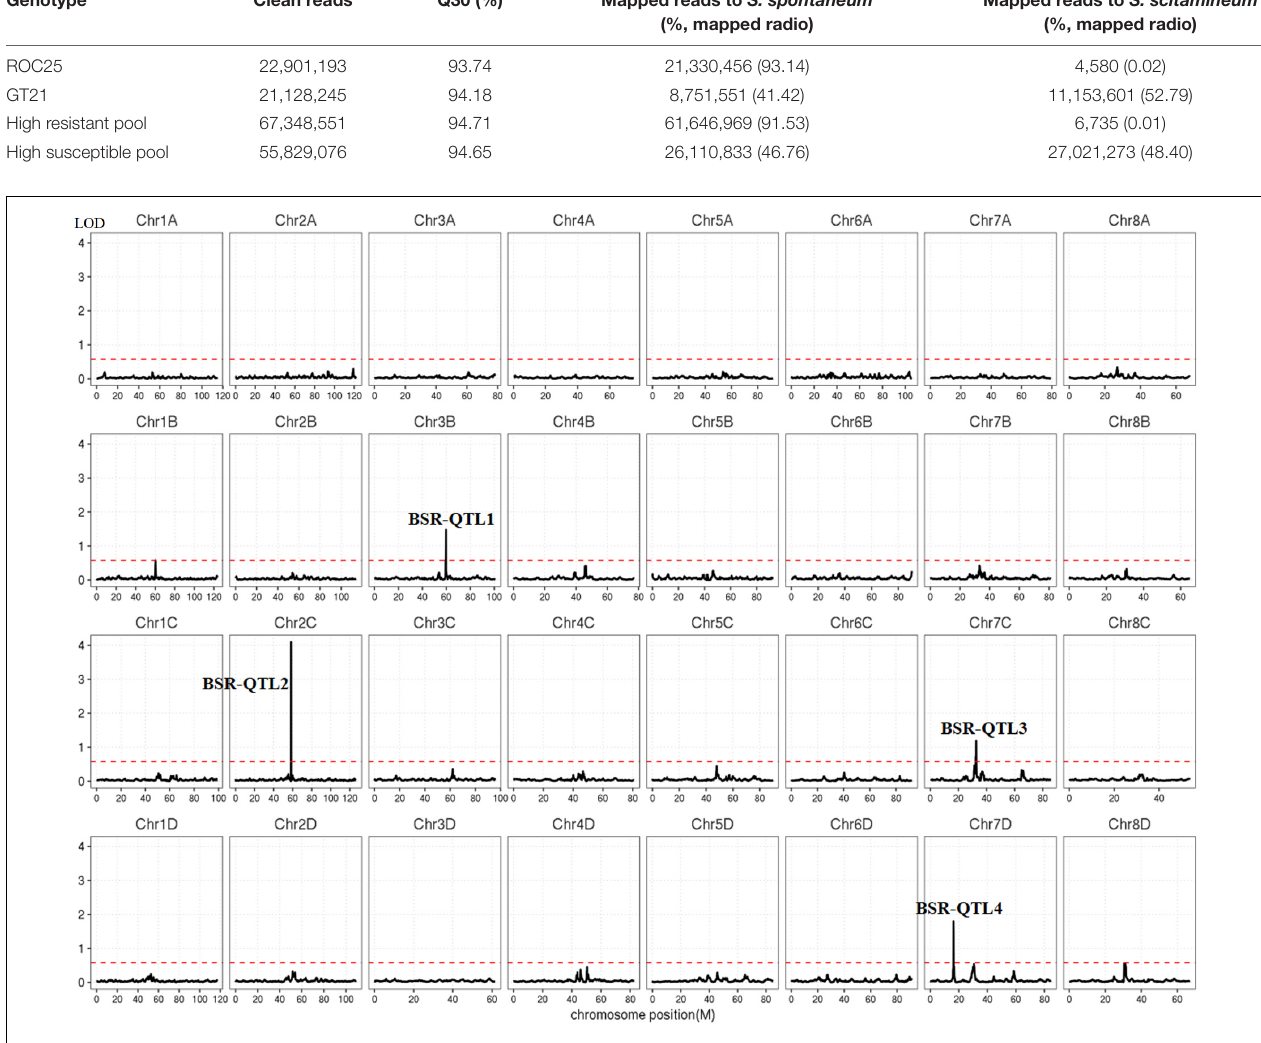
FIGURE 4 | The distribution of QTLs associated with smut resistance in the Saccharum spontaneum AP85-441 genome. The dotted line represents the threshold (0.578).